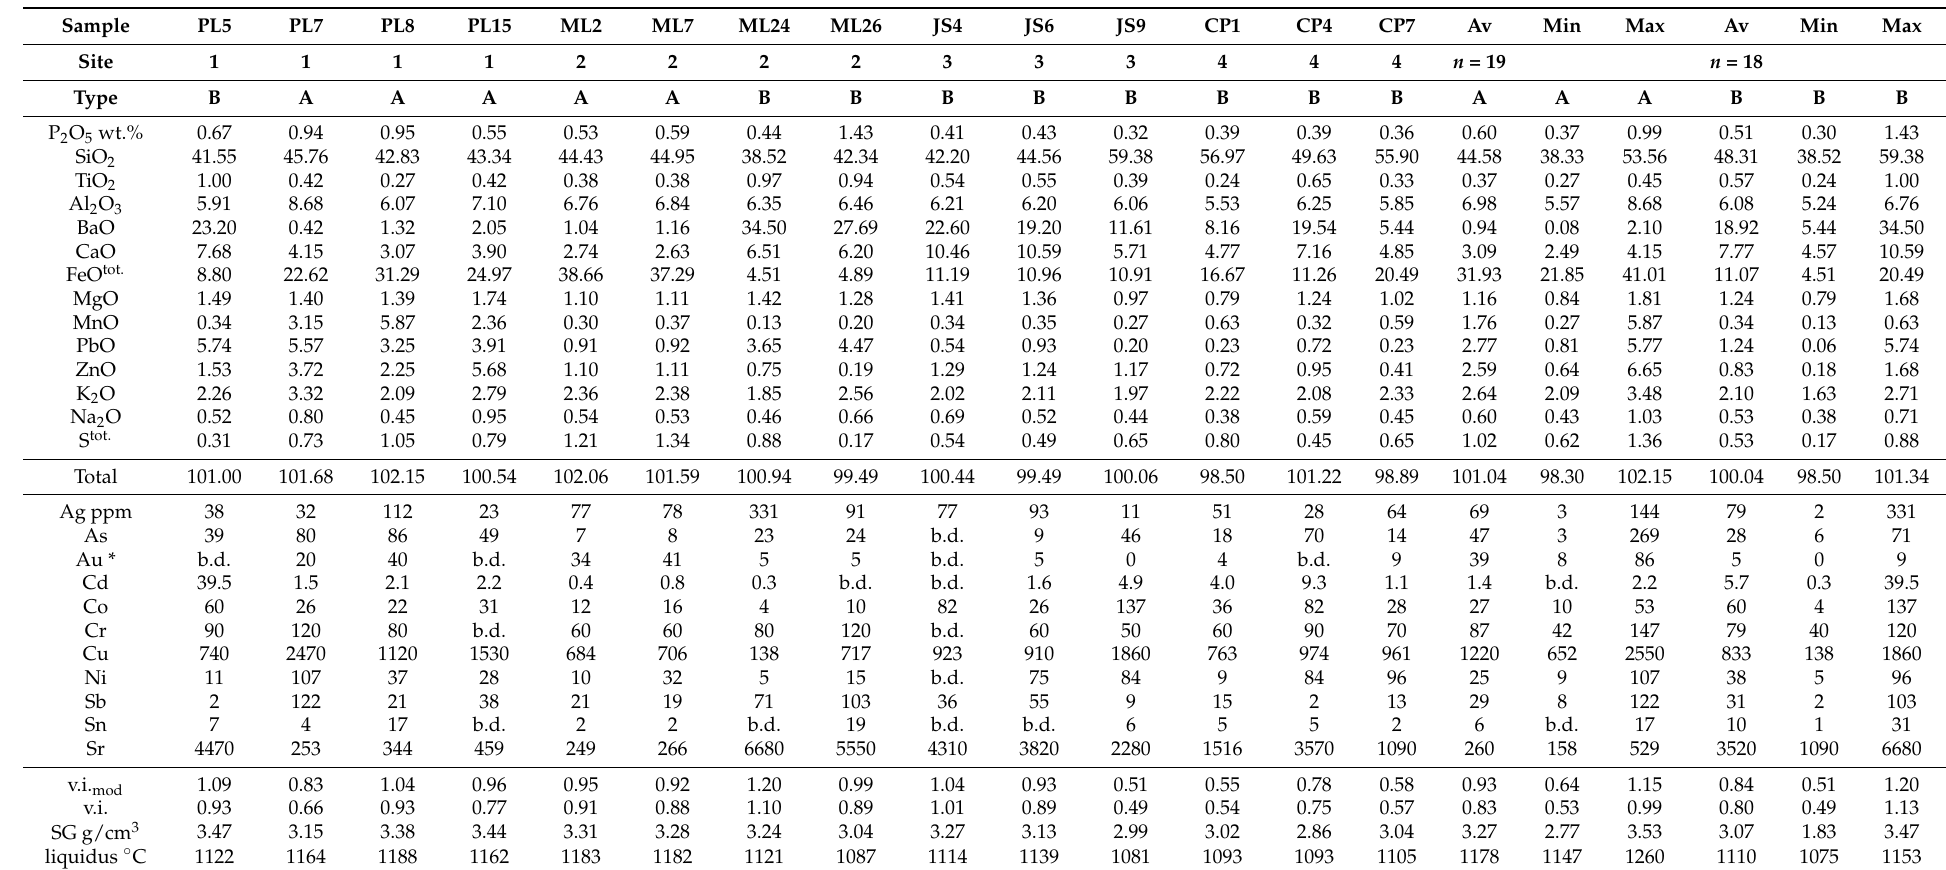
Table 1. Bulk chemical composition of selected samples from studied localities in the JOD. *—ppb, Av—average, SG—specific gravity, b.d.—below the limit of detection, v.i.—viscosity index (calculated according to [1]), v.i. mod —viscosity index taking into account high PbO and ZnO contents (calculated according to [8]), liquidus—calculated by MELTS software